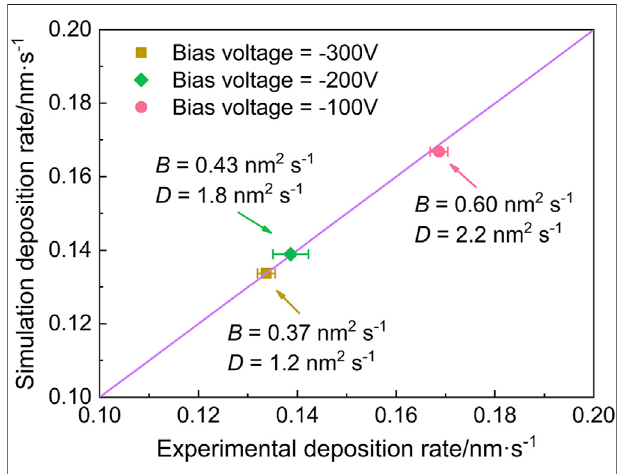
FIGURE 4 | Comparison of the deposition rate of TiN coatings between the phase- fi eld simulation results during PVD growth applying different vapor – solid transition velocities (i.e., B ) and diffusion coef fi cients (i.e., D ) and the experimental data with various bias voltage (Wang et al., 2015).